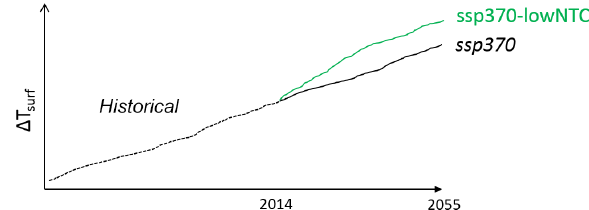
Figure 1. Schematic of future coupled-ocean simulations based on the SSP3-7.0